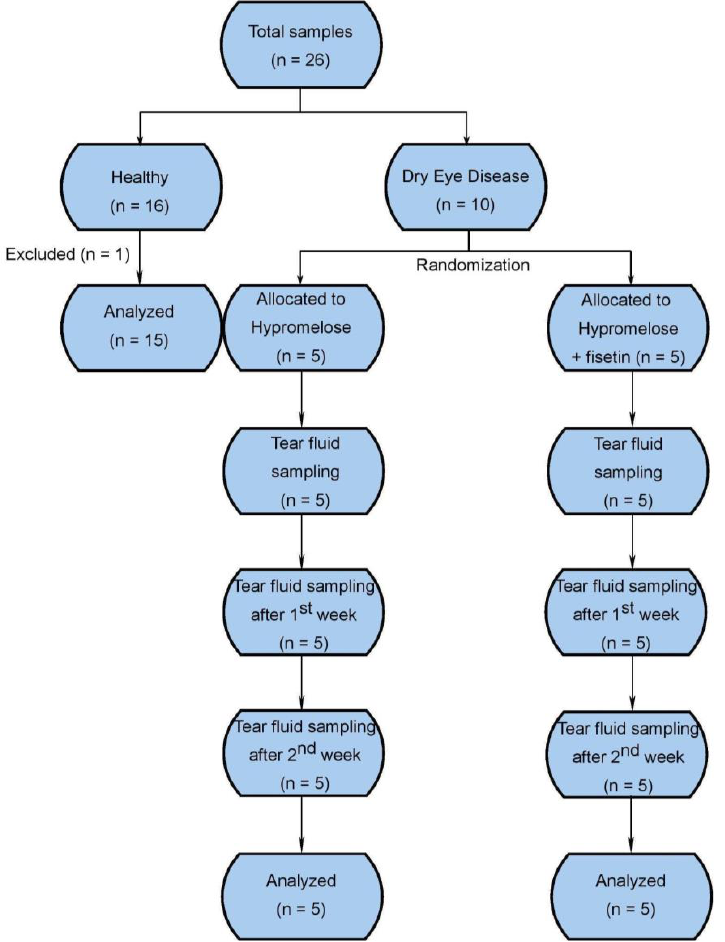
Figure 1. Design of the clinical study; n — number of eyes. Table 1. Demographics and Baseline